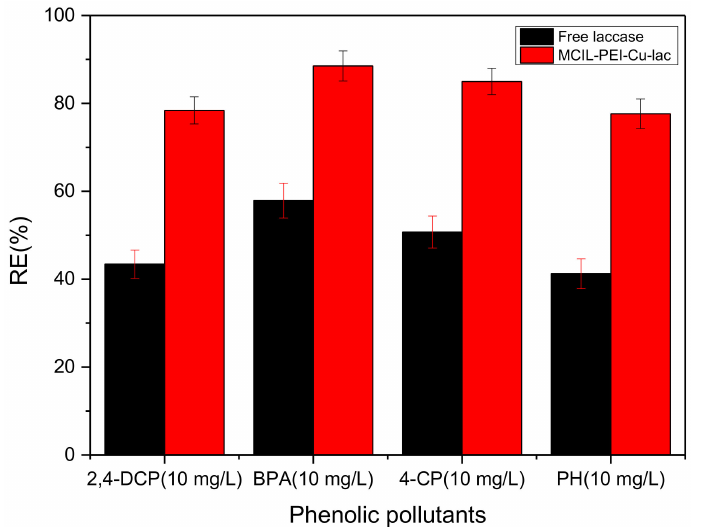
Figure 7. Removal efficiency of other phenolic pollutants by free laccase and